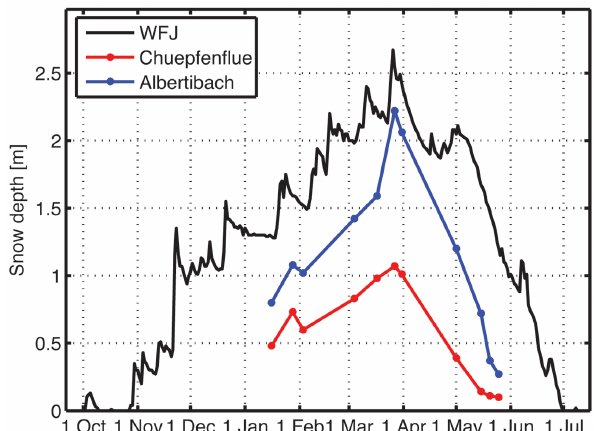
Fig. 3. Course of the snow depth measured daily at the Versuchs- feld Weissfluhjoch (WFJ) and the mean snow depth (HS tot , calcu- lated for the entire base area) of the rock face Ch¨upfenflue and the Albertibach catchment from winter 2008/2009.